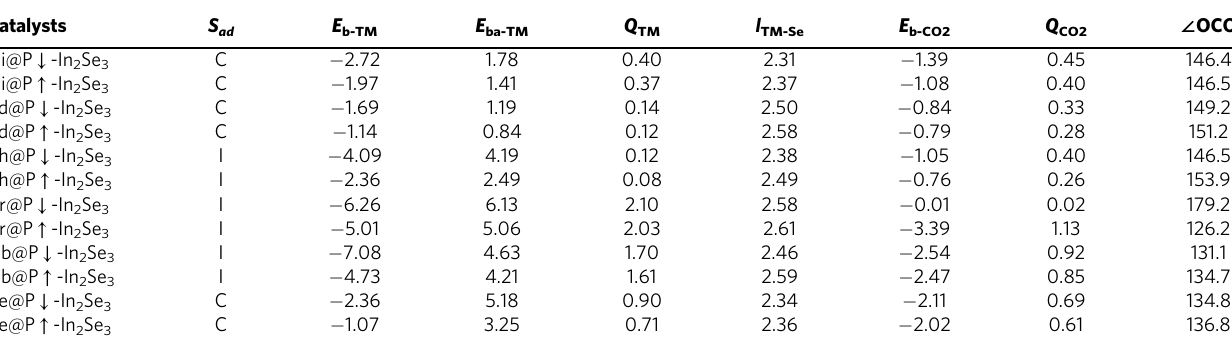
Table 1 Parameters for the pure TM@In 2 Se 3 and CO 2 adsorbed TM@In 2 Se 3 : adsorption site ( S ad ), binding energies of TM atom ( E b-TM in eV/atom) and CO 2 molecule ( E b-CO2 in eV/molecule), charge lost from the adsorbed TM atoms ( Q TM in e /atom), average TM-Se bond length ( l TM-Se in Å), migration barrier ( E ba-TM in eV), charge gained by the adsorbed CO 2 molecule ( Q CO2 in e /molecule), and bond angle ( ∠ OCO in